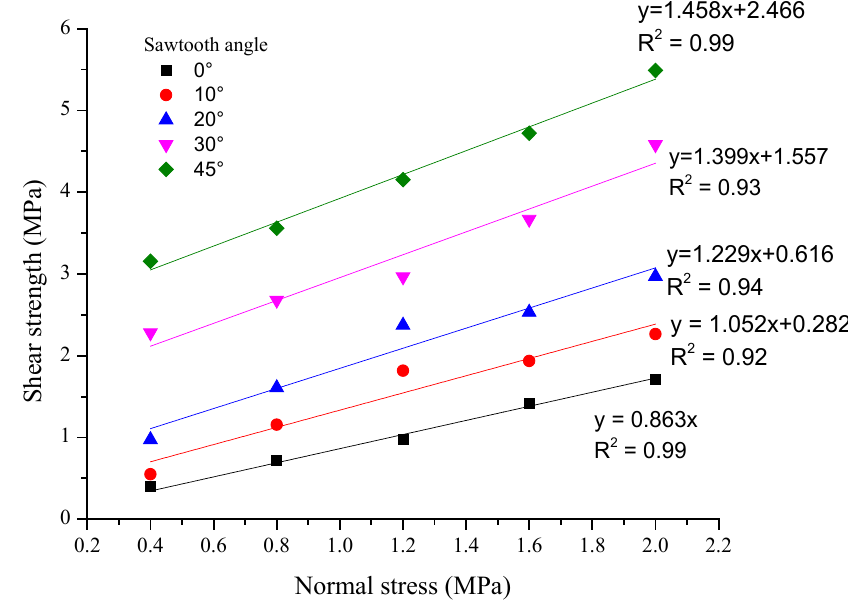
Figure 4. Shear strength under different normal stresses.